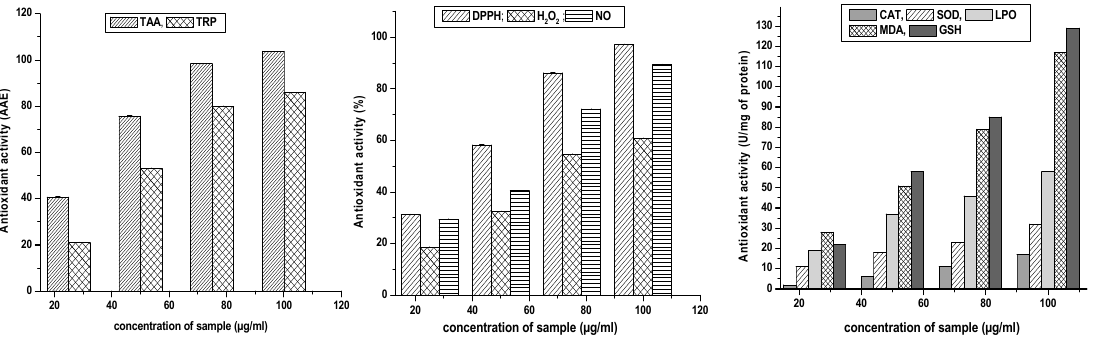
Figure 9. Antioxidant activity of marine archaeal EPS from Halococcus sp. AMS12.